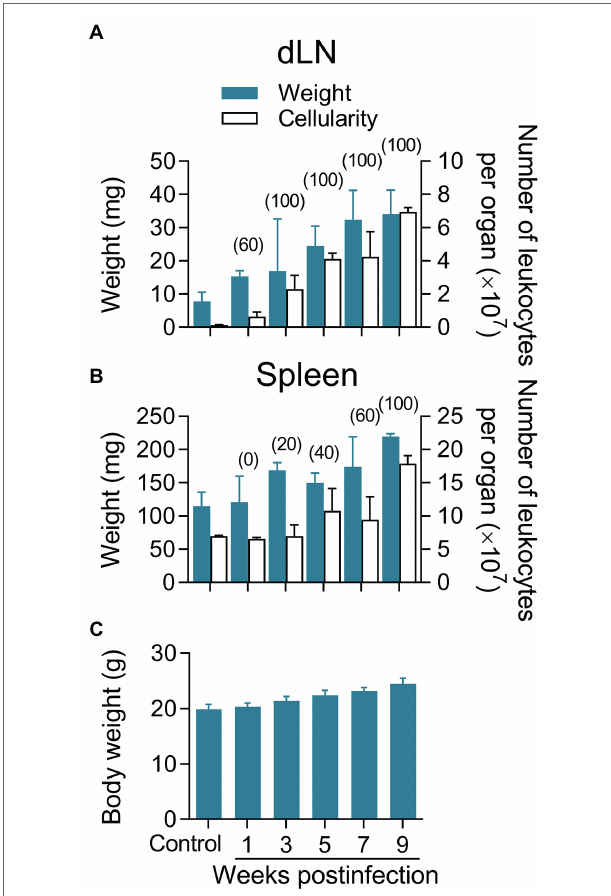
FIGURE 3 | Lymphadenopathy and parasite dissemination in the absence of systemic disease. Mice infected as indicated in Figure 2 were used to remove the dLN in order to determine the weight and cellularity of the organ (A) . The spleens were also obtained for a similar analysis (B) . Blue bars indicate the weights, and white bars show the number of leukocytes (A,B) . Cell suspensions from both organs were also cultured to determine the percentage of mice harboring viable parasites at the indicated timepoint, which is shown in the top of the bars in parenthesis (A,B) . As an indicator of overall health, the total body weight per mouse was also determined at the indicated time (C) . A group of non-infected mice was also analyzed as controls for comparison purposes. Healthy BALB/c mice of the same age gained approximately 0.5 g of body weight per week, which lies within the normal ranges reported by the commercial supplier. Data correspond to individual analysis of 3–6 mice per time. The results are expressed as median ± interquartile